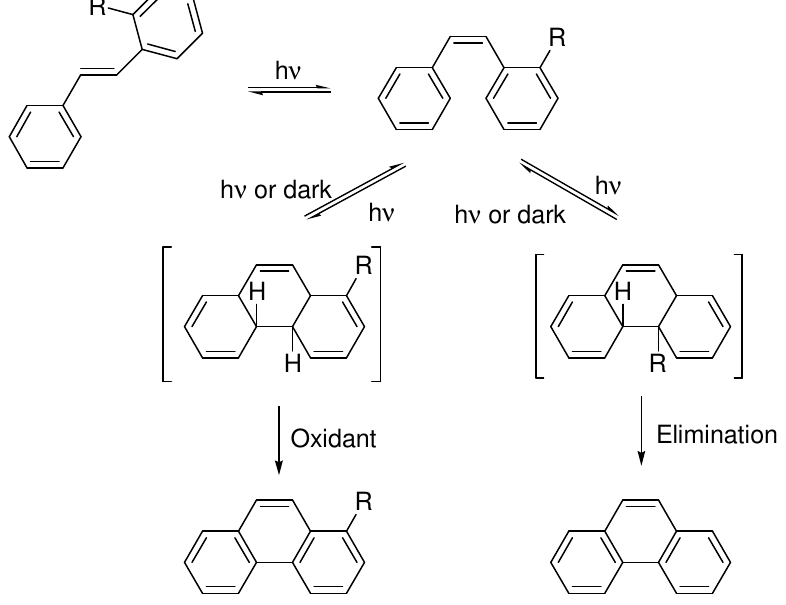
Scheme 1. Reaction pathways for the photocyclization of